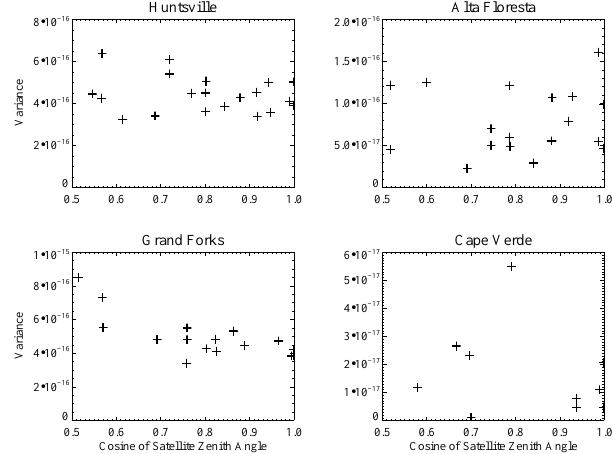
Figure 5. Variance of VIIRS radiance values vs. the cosine of the average satellite zenith angle for each night that a retrieval is made, separated by location.